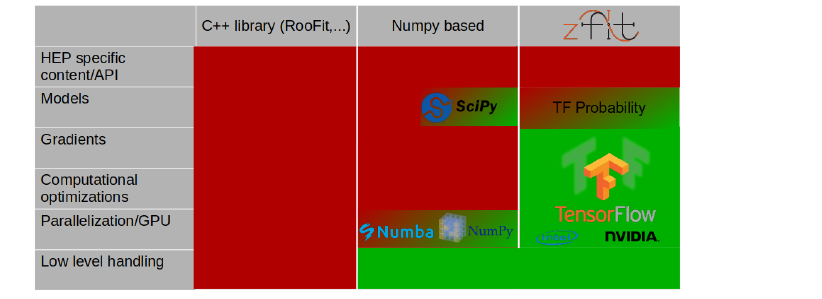
Figure 2. Comparison of the responsibilities of di ff erent approaches to build a fitting library. While Numpy and Python provide more convenience than C ++ implemented tools, TF takes a lot of the required optimizations and leaves only a small part to a library that builds on